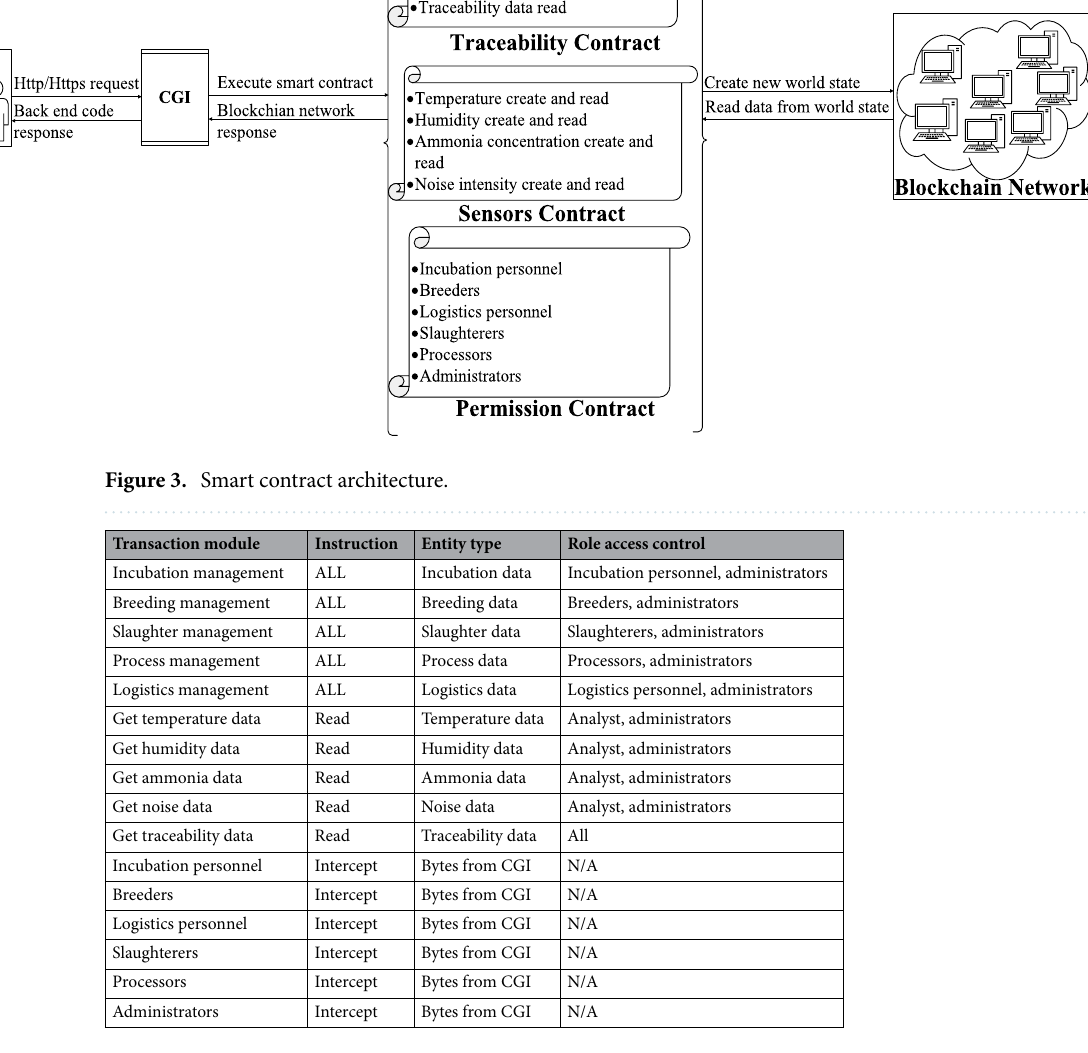
Table 1. Smart contract